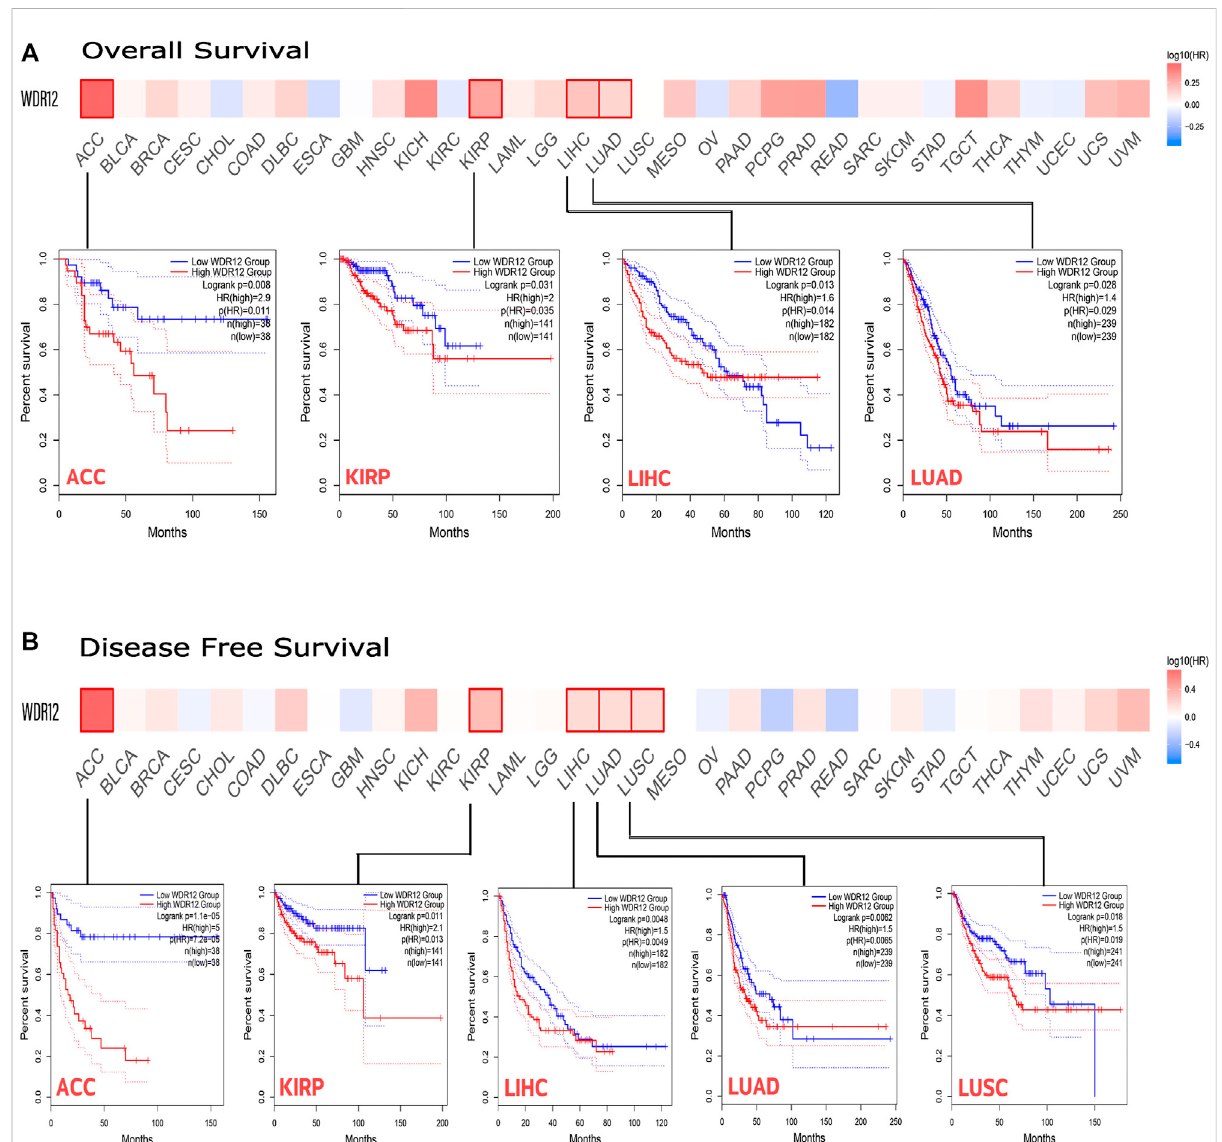
FIGURE 3 The correlation between WDR12 expression and the clinical outcome. (A) disease-free survival; (B) overall survival as assessed from the GEPIA